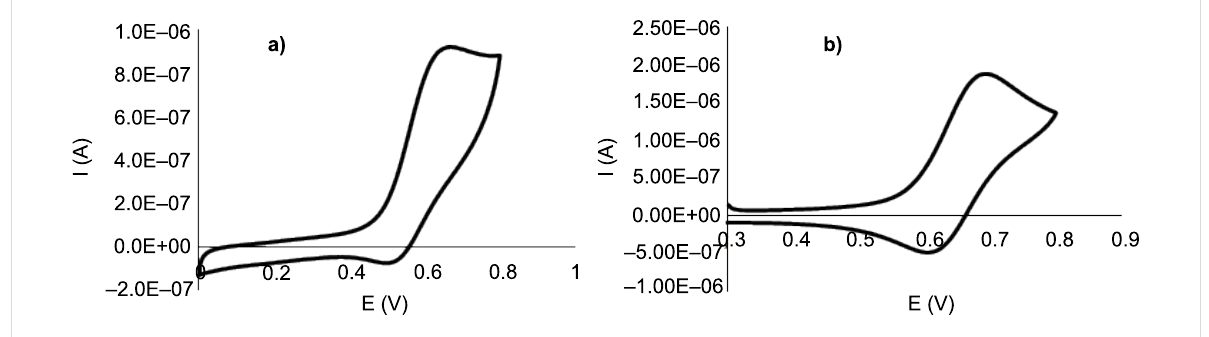
Figure 1: CV plots of complexes 2 (a), and 3 (b). Experiments were carried out using 1 mM solutions of the complexes in dry CH 2 Cl 2 with 0.1 M [NBu